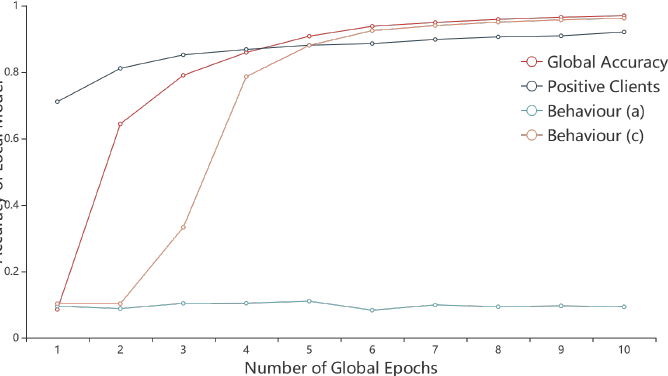
Figure 5. The comparison of local model accuracy between negative clients and positive clients in